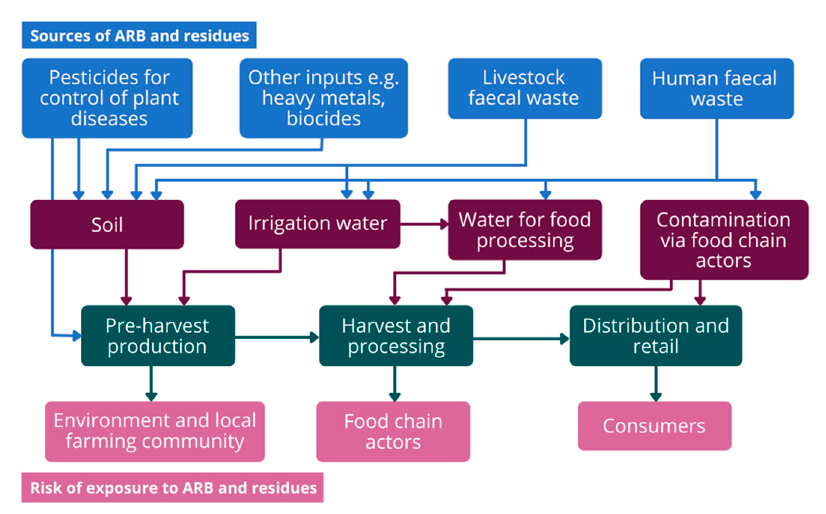
Figure 1. Antimicrobial resistance (AMR)-relevant pre- and post-harvest inputs in the food crop value chain.